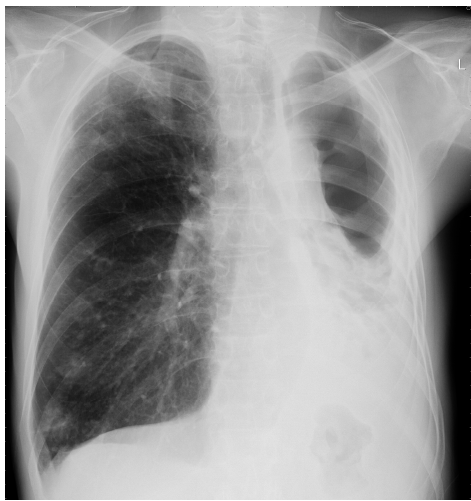
Figure 4. CFPA of the left lung with associated cavitation and volume loss.